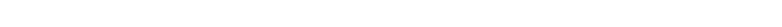
Table 1 Hypotheses set for construct validity